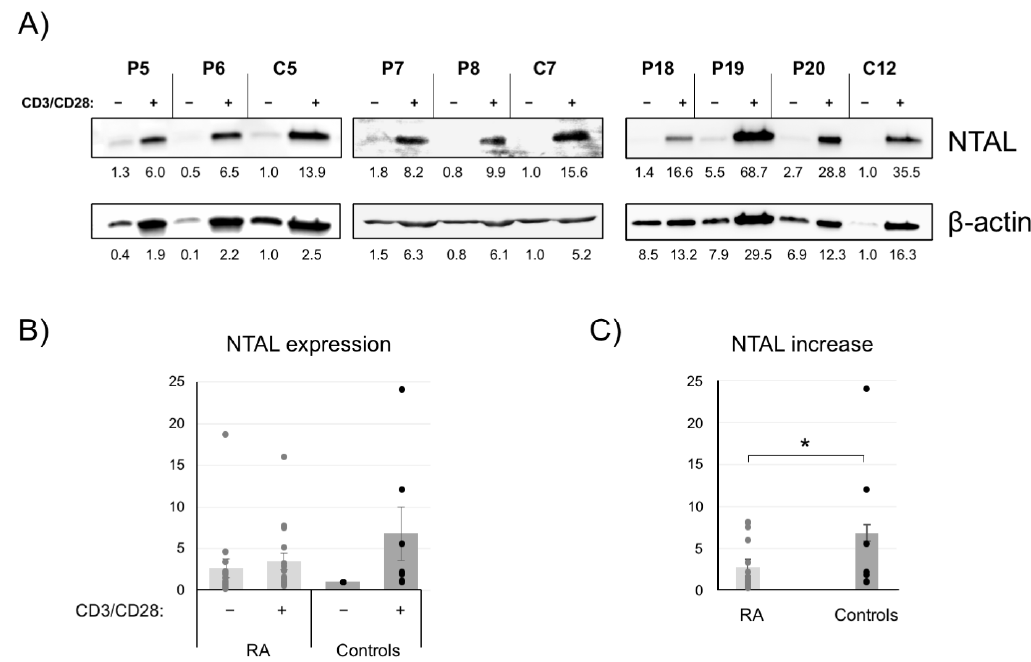
Figure 4. Increased NTAL expression induction in CD4+ T lymphocytes from RA patients. ( A ) NTAL expression analyzed by Western blot in the cell lysates of resting or CD3/CD28-stimulated CD4+ T cells from healthy controls (C) or RA patients (P). Membranes were stripped and reblotted with anti- β -actin antibody to normalize NTAL expression. ( B ) Graphics depicting the relative expression of NTAL in resting or CD3/CD28-activated CD4+ T cells from 16 RA patients and 7 healthy controls. In every single experiment a value of 1.0 was assigned to the corresponding control to determine the relative level of NTAL and β -actin expression. Circles represent individual data points. Bars represent the standard error. ( C ) Graphics representing the relative increase in NTAL expression in CD4+ T cells from RA patients and healthy controls. Bars represent the standard error. The asterisk represents statistical significance ( p < 0.05) using a two-tailed t -test.